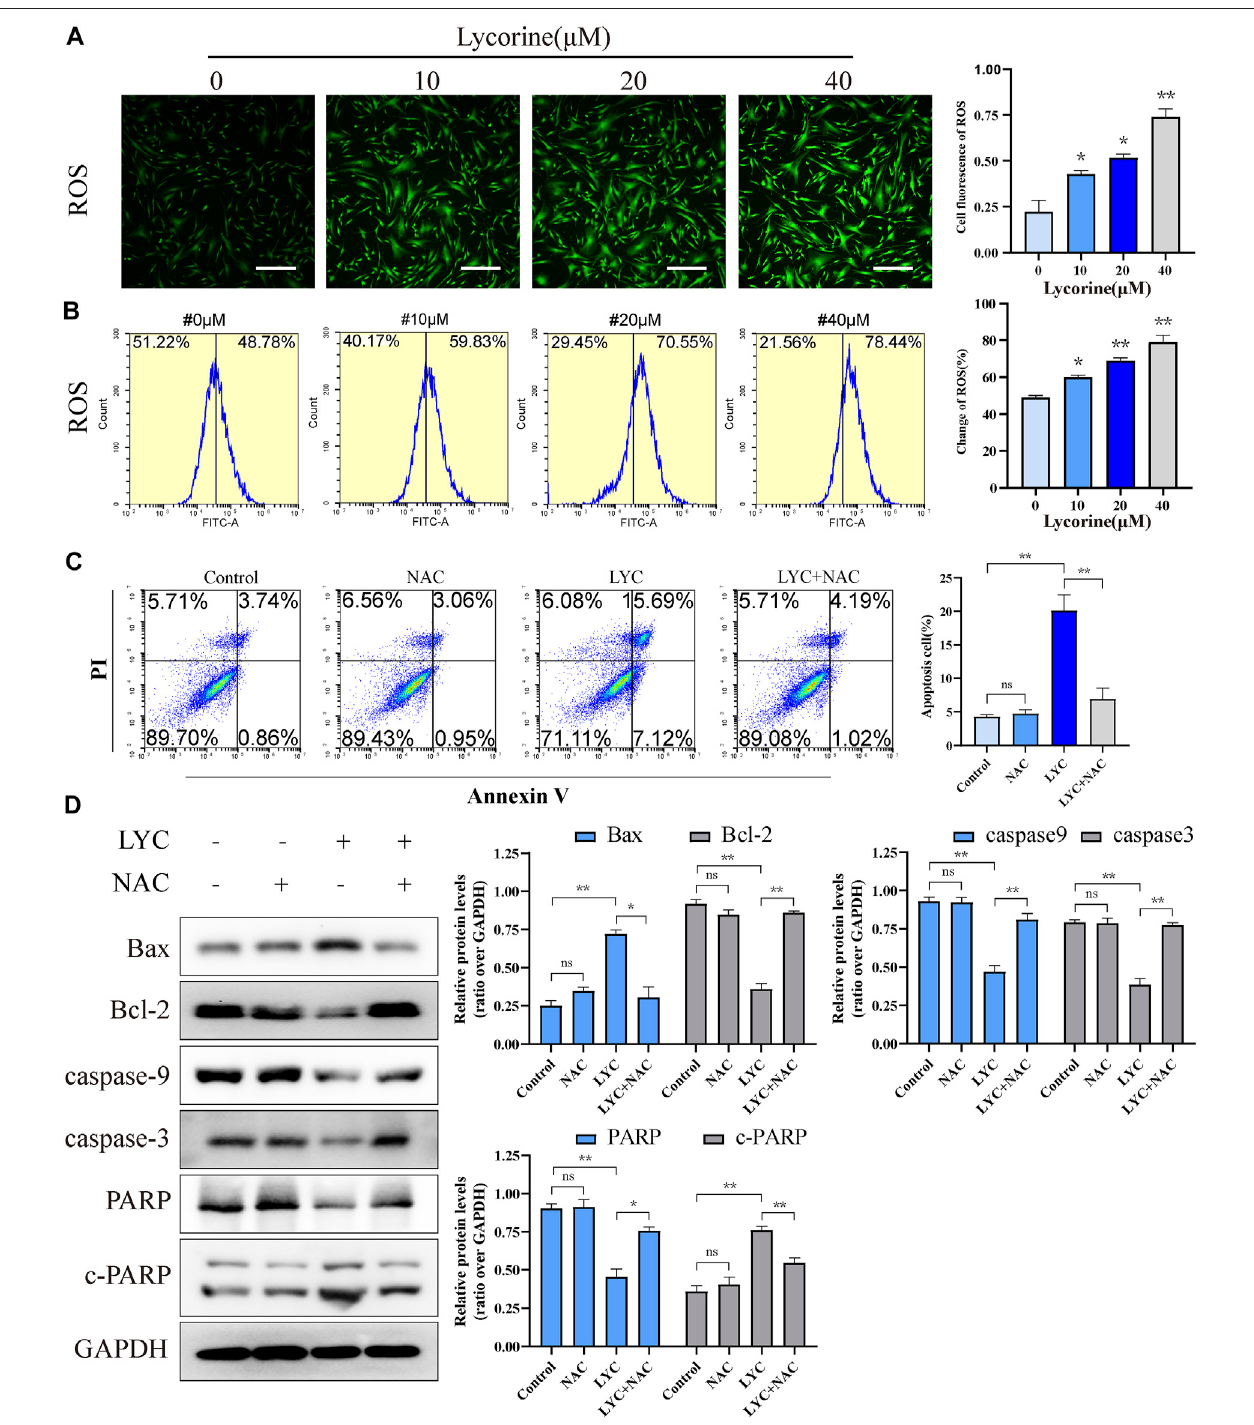
FIGURE4| Lycorinestimulateshighlevelsofreactiveoxygenspecies(ROS) production, leadingtotheapoptosis ofHSFs. (A – B)HSFsweretreatedwithvehicle or lycorineatindicatedconcentrations.Thelevelsofintracellular ROSwereanalyzedby (A) immuno fl uorescence( n =4,Scalebar =400 μ M)and (B) fl owcytometry( n =4). (C) FlowcytometricanalysisofthepercentagesofapoptoticHSFsfollowingtreatmentwithvehicle(control)or40 μ Mlycorineinthepresenceorabsenceof100 μ MNAC for 24 h ( n = 4). (D) The relative levels of a-smooth muscle actin (a-SMA), collagen I, and collagen III expression in the different groups of cells were analyzed by Western blot ( n = 3). Data are mean ± standard error of the mean. * p < 0.05, ** p < 0.01, *** p < 0.001.